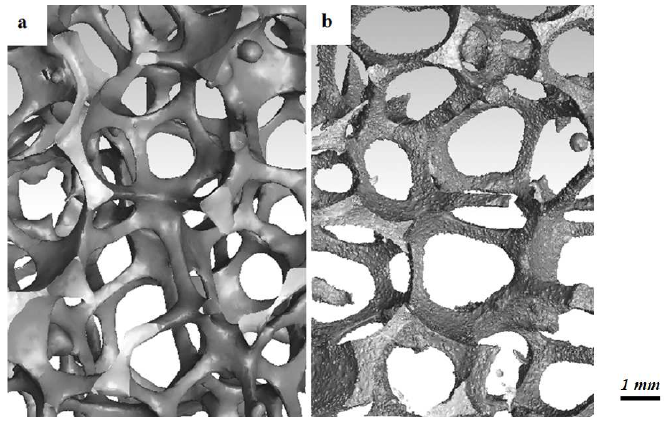
Figure 5. An illustration of the effect of voxel size for a µ CT scan reconstruction with respectively a ( a ) 37.5 µ m and a ( b ) 8.5 µ m voxel size. Foam samples are made